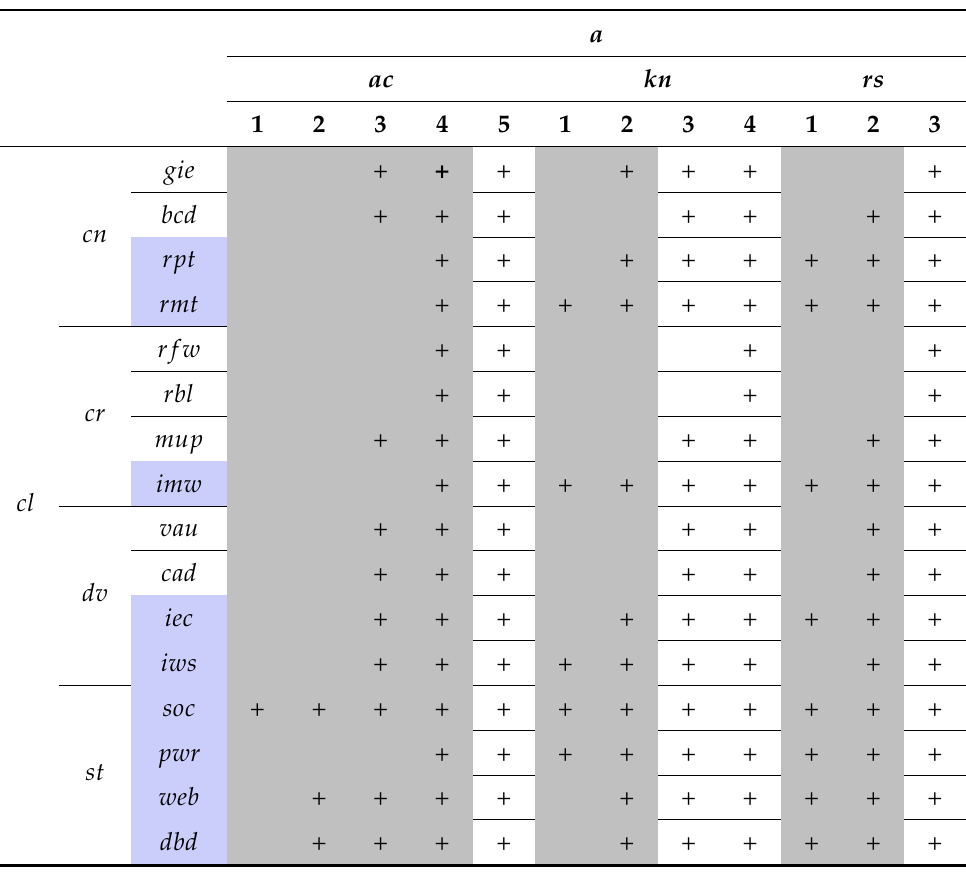
Table 5. Classes of attack actions and different types of